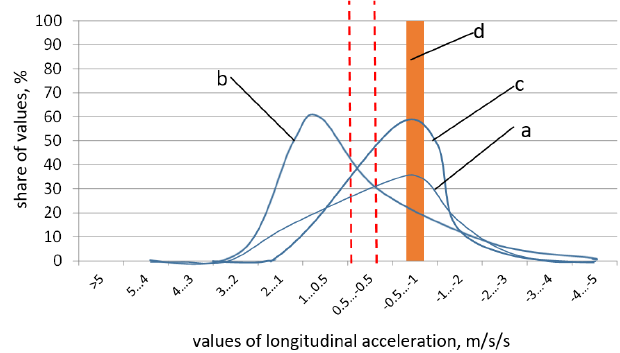
Figure 12. Breakdown of longitudinal acceleration curves on various road types: (a) urban area (city); (b) non-urban area (single roadway with two traffic lanes); (c) two-roadway expressway; (d) motorway.